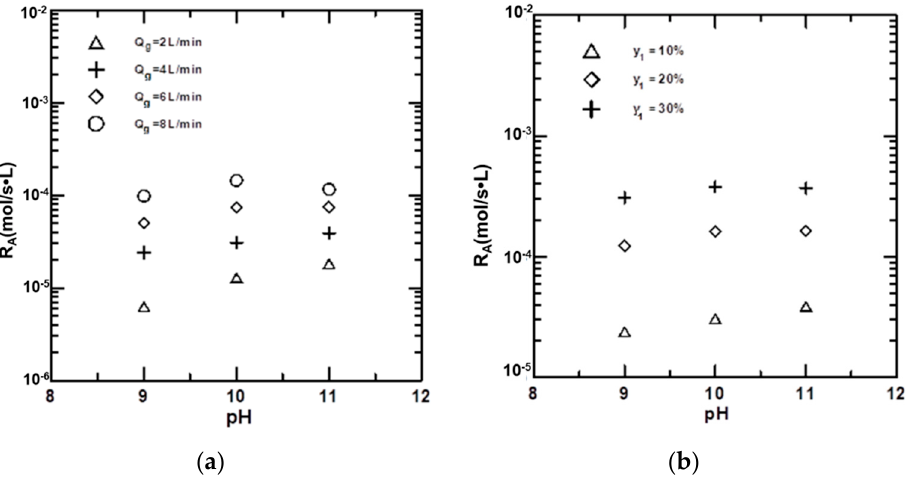
Figure 7. Effects of process variables on the absorption of CO 2. ( a ) Effects of pH at different gas-flow rates; ( b ) Effects of pH at different gas concentrations.